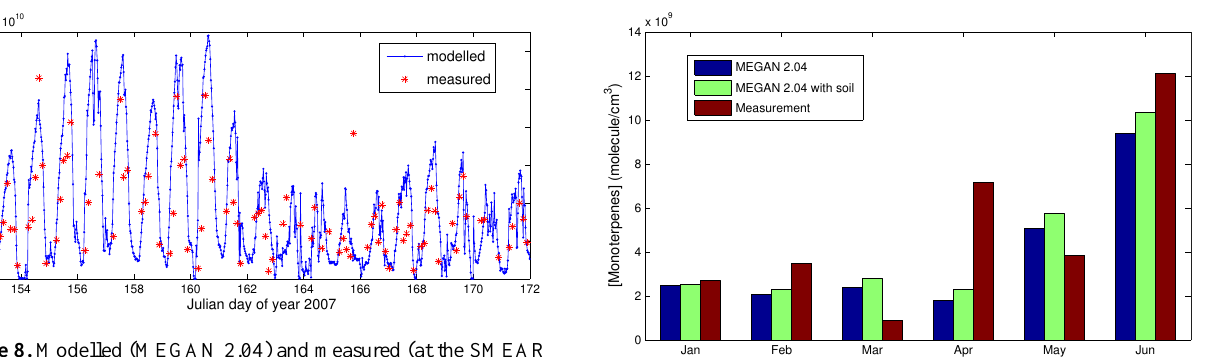
Figure 8. Modelled (MEGAN 2.04) and measured (at the SMEAR II station) monoterpene flux at 22m height in June 2007.